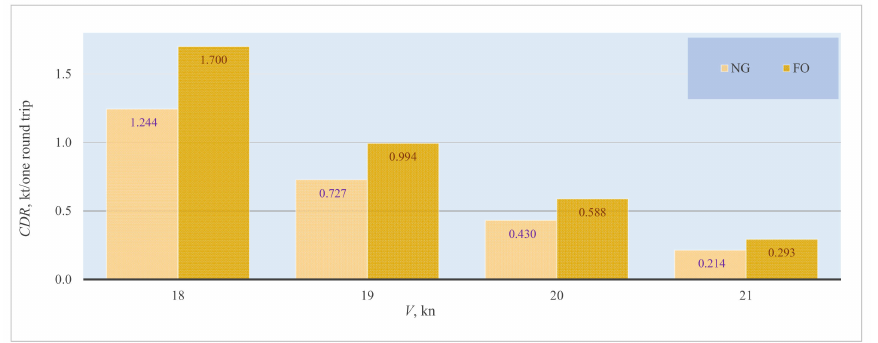
Figure 27. The CO 2 emission reduction per one trip for FO- and NG-fueled mode under HWC.